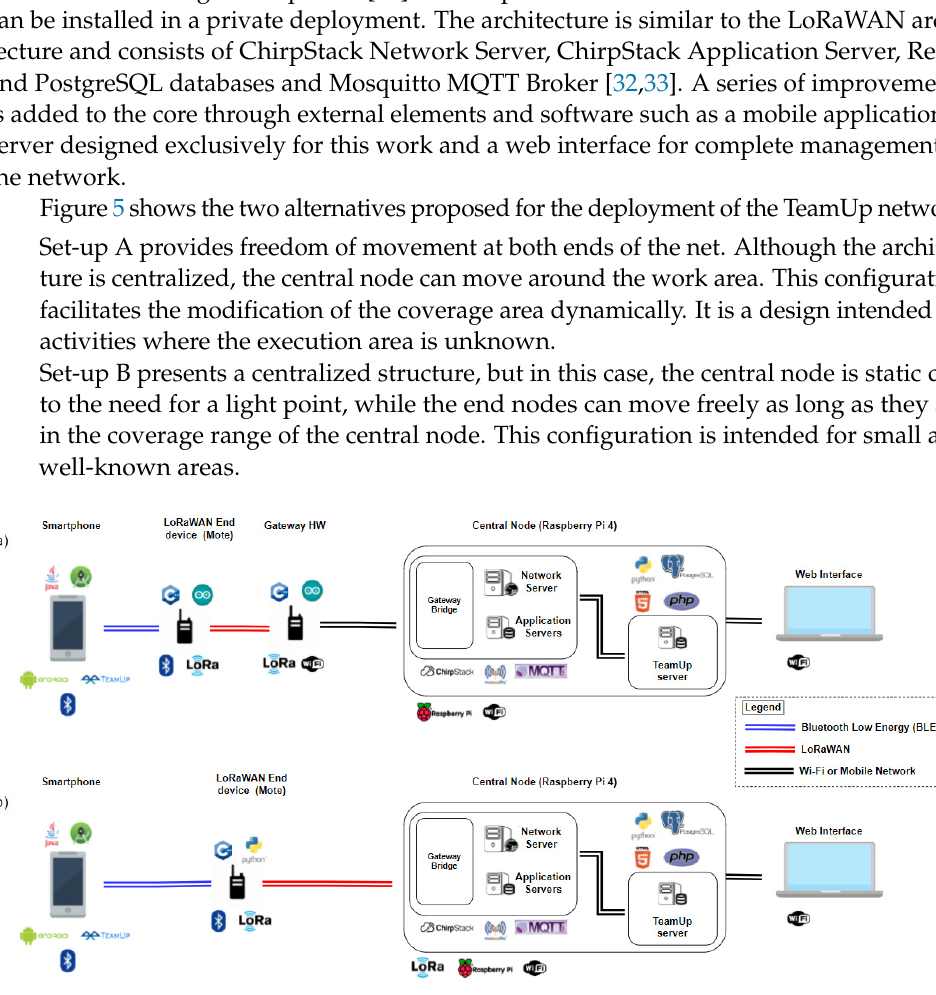
Figure 5. TeamUp network designs. ( a ) Mobility design using a hardware gateway and central node without LoRa. ( b ) Static design using a central node with LoRa.